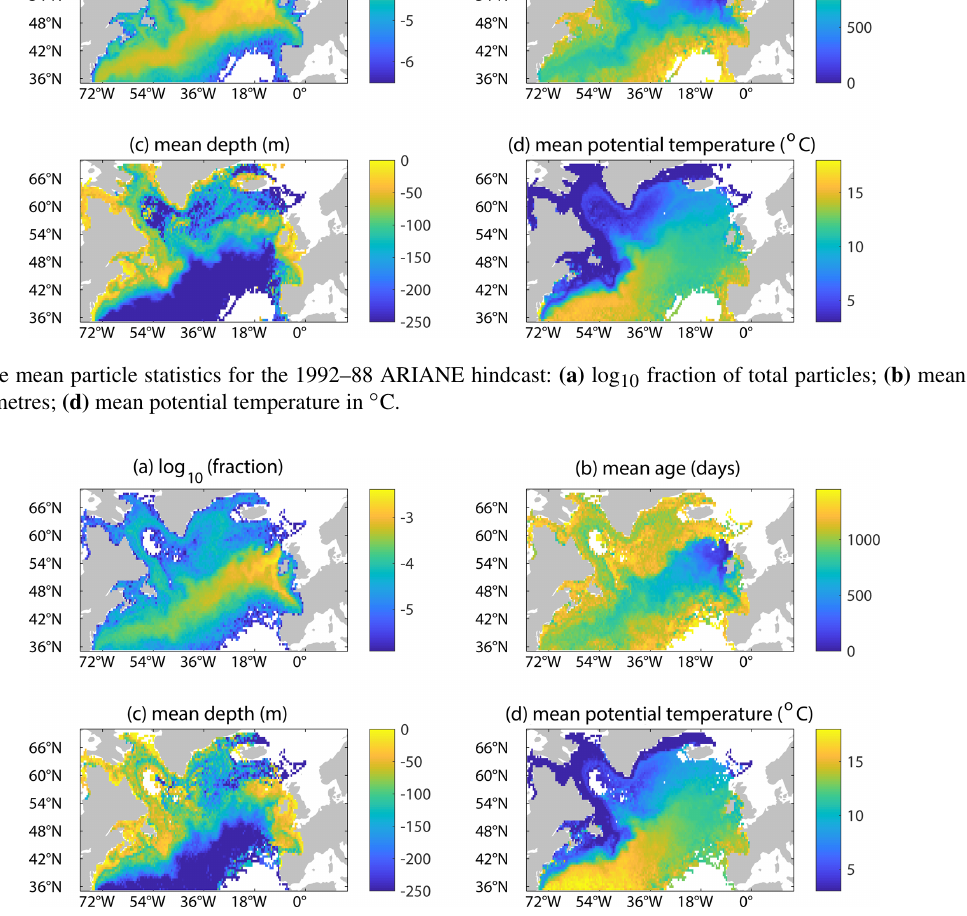
Figure 10. Ensemble mean particle statistics for the 2010–06 ARIANE hindcast: (a) log 10 fraction of total particles; (b) mean age in days; (c) mean depth in metres; (d) mean potential temperature in ◦